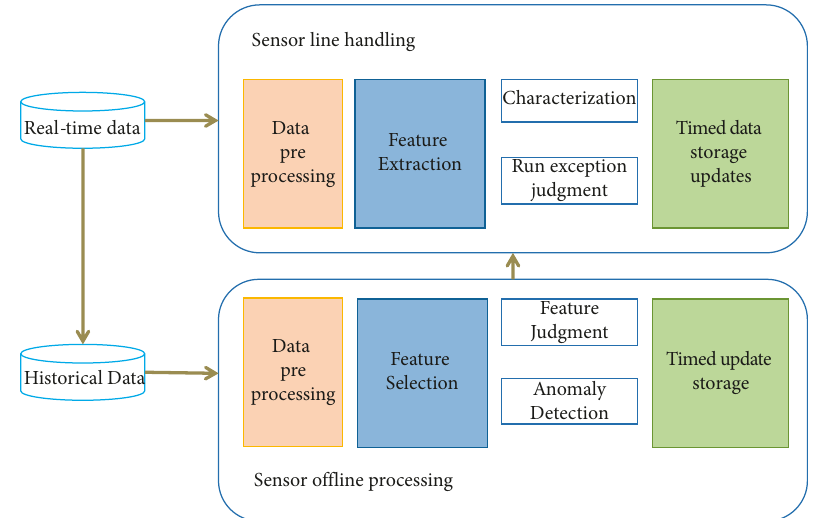
Figure 4: Multisource data signal sensor structure schematic.